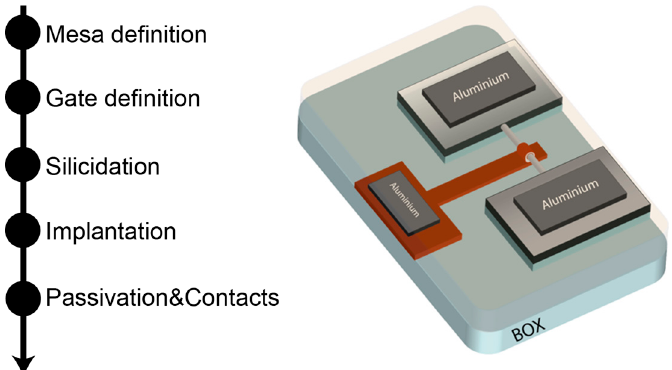
Figure 1. Fabrication process steps as well as schematics of the final device structure of the single nanowire (NW) tunnel field effect transistors (TFETs).